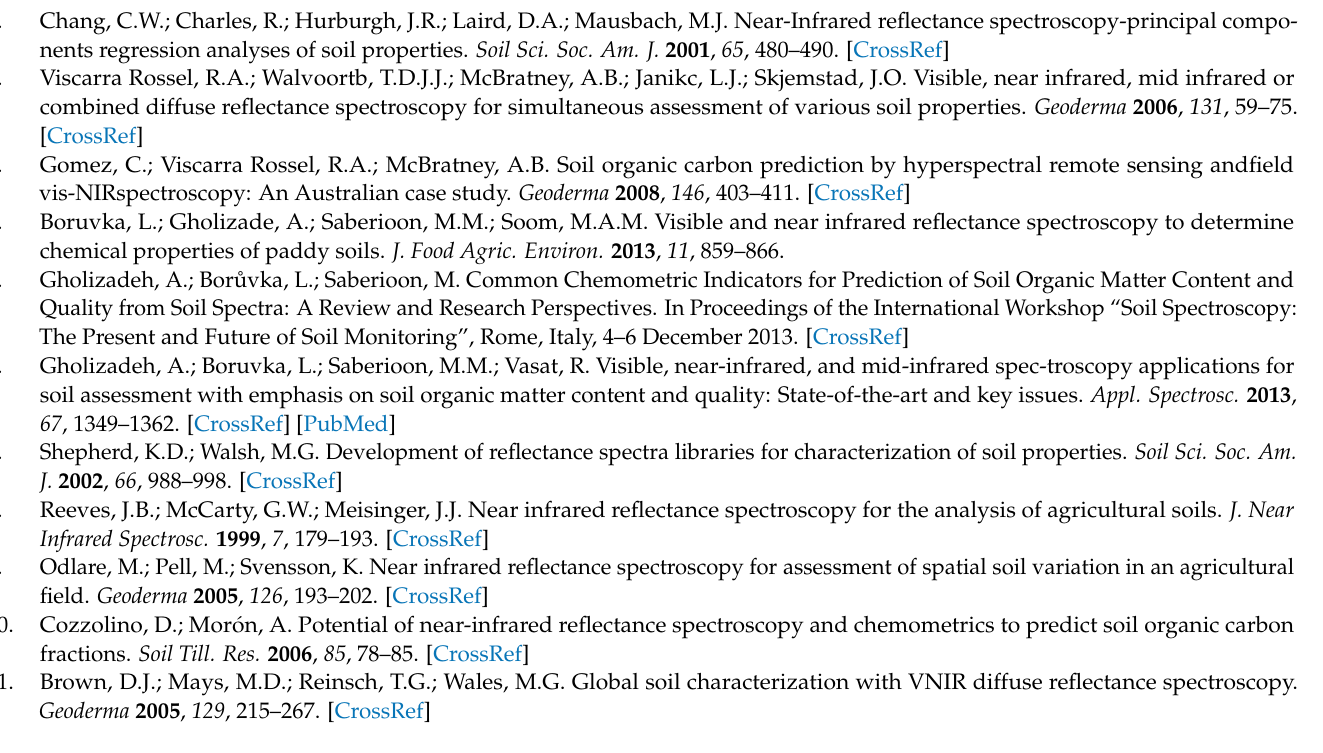
soils with different pre-processing methods: without smoothing–no derivation (None-0-Raw data); Figure S2: Spectra of soils with different pre-processing methods: smoothing Savitzky–Golay and a search window of 3; Savitzky–Golay 1st derivation and 1st order polynomial (SG3-SG1-); Figure S3: Spectra of soils with different pre-processing methods: smoothing Savitzky–Golay, a search window of 3, Savitzky–Golay 2nd derivation, and 2nd order polynomial; Figure S4: Spectra of soils with different pre-processing methods: a moving average search window of 11 segments and no derivation (MA11-raw-); Figure S5: Spectra of soils with different pre-processing methods: a moving average search window of 25 segments and no derivation (MA25-raw-); Figure S6: Spectra of soils with different pre-processing methods: Savitzky–Golay, 0 order polynomial, a search window of 11 segments, and without derivation (SG11-raw-); Figure S7: Spectra of soils with different pre- processing methods: Savitzky–Golay, 0 order polynomial, a search window of 25 segments, and without derivation (SG25-raw-); Figure S8: Spectra of soils with different pre-processing methods: Savitzky-Golay, 1st derivation, 1st order polynomial, and a search window of 11 segments (SG11-SG1-); Figure S9: Spectra of soils with different pre-processing methods: Savitzky–Golay, 2nd derivation, 2nd order polynomial, and a search window of 11 segments (SG11-SG2-); Figure S10: Spectra of soils with different pre-processing methods: Savitzky–Golay, 1st derivation, 1st order polynomial, and a search window of 25 segments (SG25-SG1-); Figure S11: Spectra of soils with different pre- processing methods: Savitzky–Golay, 2nd derivation, 2nd order polynomial, and a search window of 25 segments (SG25-SG2-); Table S1: Pre-treatments applied to the reflectance spectra with statistics of calibration and validation for different soil